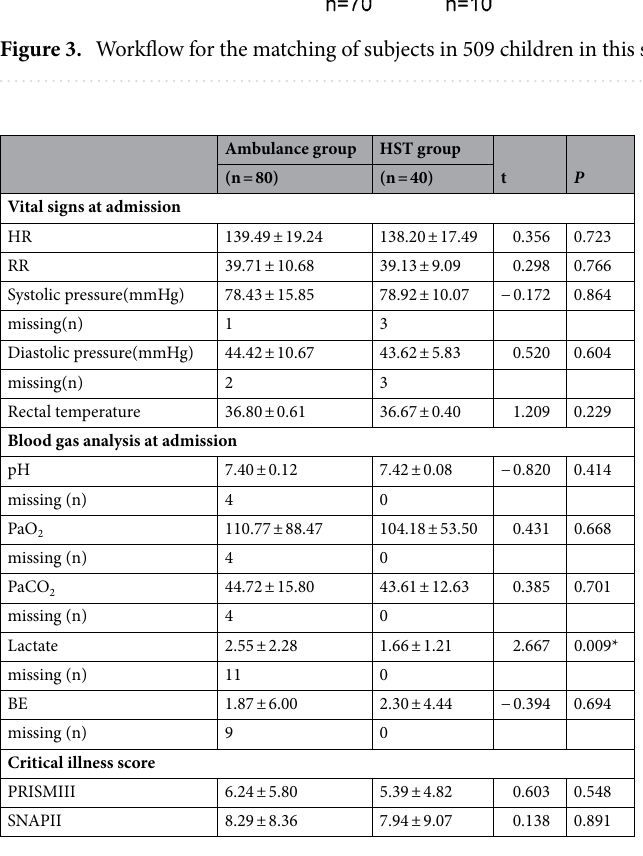
Table 1. Comparison of vital signs and blood gas analysis between two groups at admission. HR: heart rate; RR: respiratory rate; BE: base excess; PRISMIII, the pediatric risk of mortality III, SNAPII, Score for neonatal acute physiology II, SNAPII; * p <